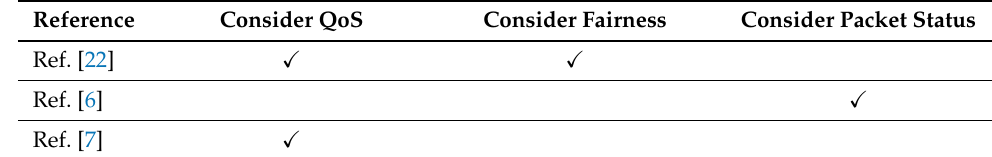
Table 2. Comparison of prior works with